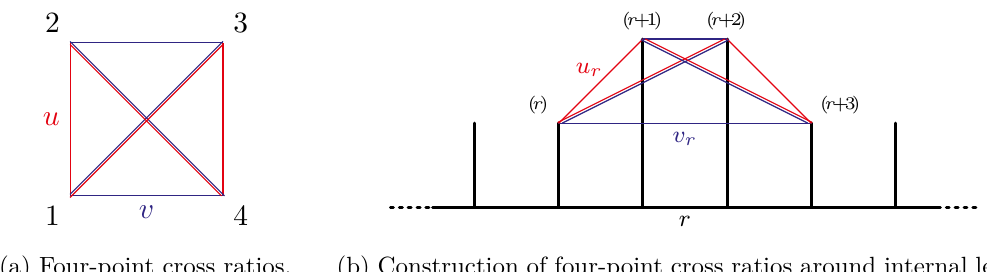
Figure 2 : Schematic representation of the four-point cross ratios u and v , where inter- secting lines correspond to terms in the denominator. The same type of cross ratios can be constructed around every internal leg by focusing on the closest four points.